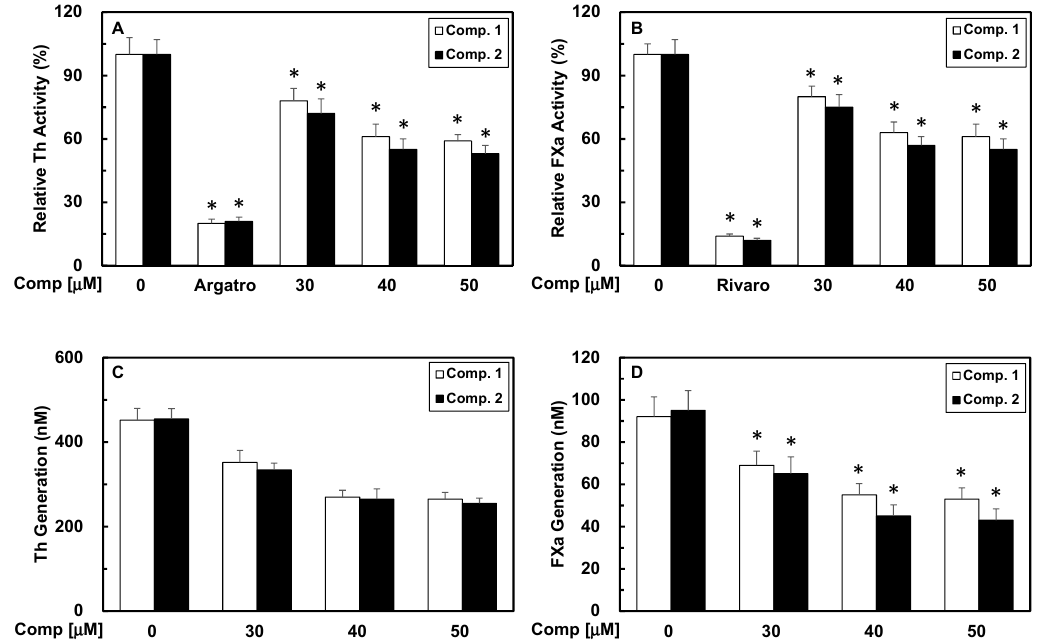
Figure 2. Effects of 1 or 2 on inactivation and production of thrombin and factor Xa. ( A ) Inhibition of thrombin (Th) by 1 or 2 was measured using a chromogenic assay, as described in the “Experimental Section”; ( B ) Inhibition of factor Xa (FXa) by 1 or 2 was monitored using a chromogenic assay, as described in the “Experimental Section”. Argatroban (A) or rivaroxaban (B) was used as a positive control; ( C ) HUVEC monolayers were pre-incubated with FVa (100 pM) and FXa (1 nM) for 10 min with the indicated concentrations of 1 or 2 . Prothrombin was added to a final concentration of 1 M and prothrombin activation was determined 30 min later, as described in the “Experimental Section”; ( D ) HUVECs were pre-incubated with the indicated concentrations of 1 or 2 for 10 min. After TNF-(10 ng/mL for 6 h) stimulated HUVECs were incubated with FVIIa (10 nM) and FX (175 nM), FXa production was determined, as described in the “Experimental Section”. D = 0.2% DMSO is the vehicle control. * p < 0.05 vs . 0.